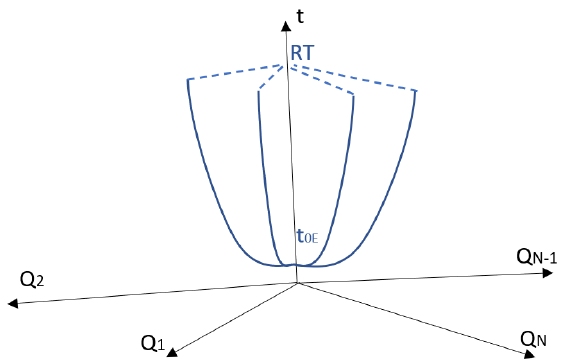
Figure 3. Multidimensional definition of Q N (t), (t 0E : time of occurrence of the earthquake E, RT: the repair time, Q i (t): recovery functions, t: time).